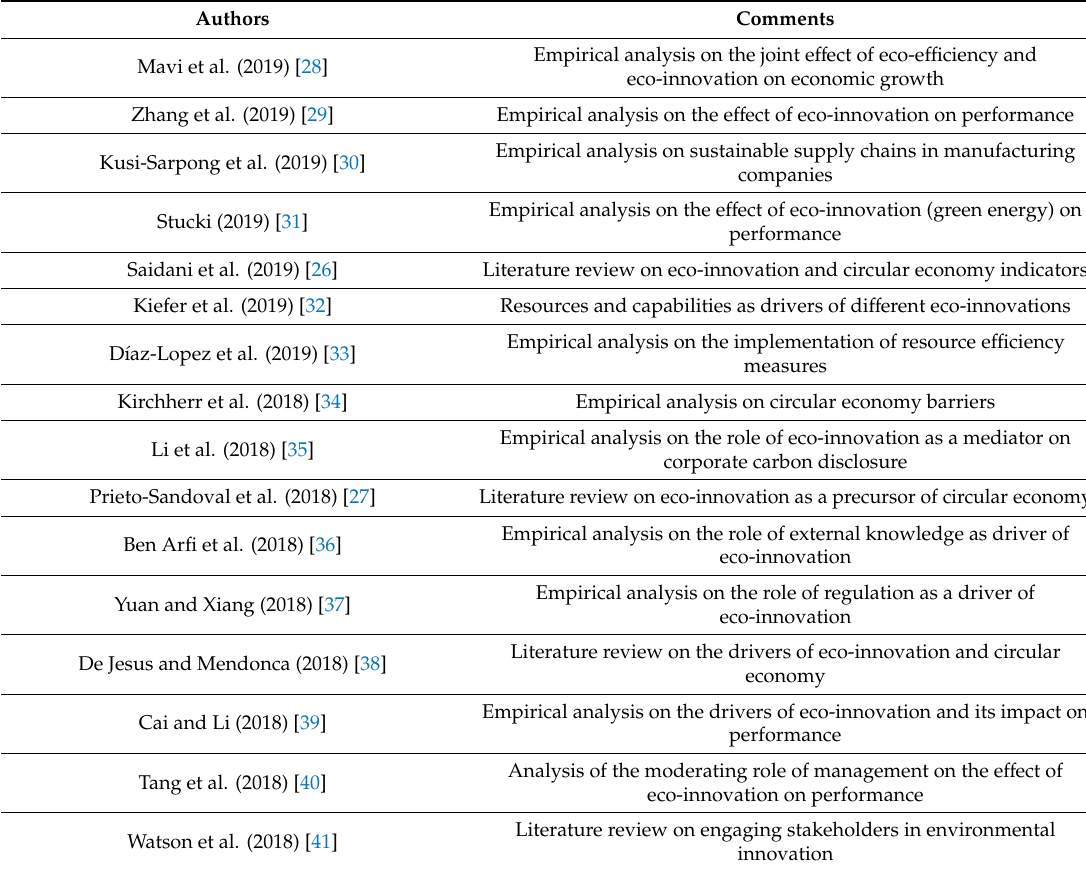
Table 1. Highly cited papers on eco-innovation from the Web of Science,